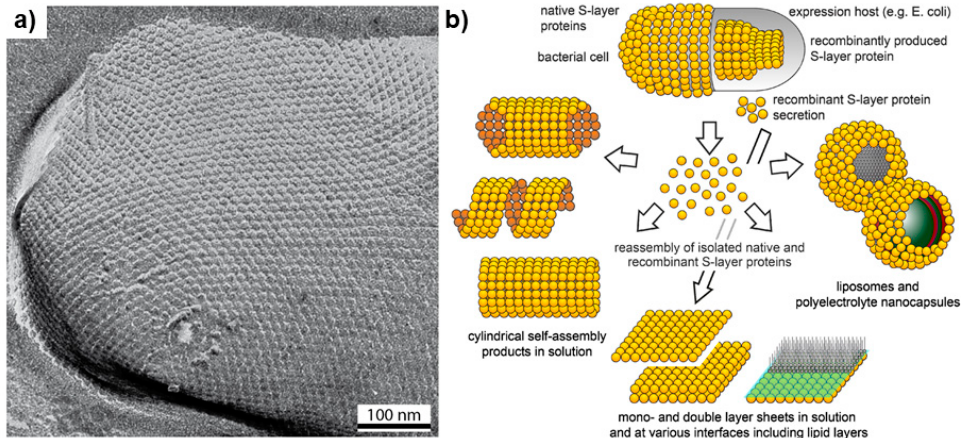
Figure 4. TEM micrograph ( a ) of an S-layer carrying Methanocorpusculum sinense cell and ( b ) the potential applications of reassembled of S-layer particles in solution, air water, and at surfaces (Adapted with permission from Pum et al. Int. J. Mol. Sci . 14 , 2484-2501 (2013)